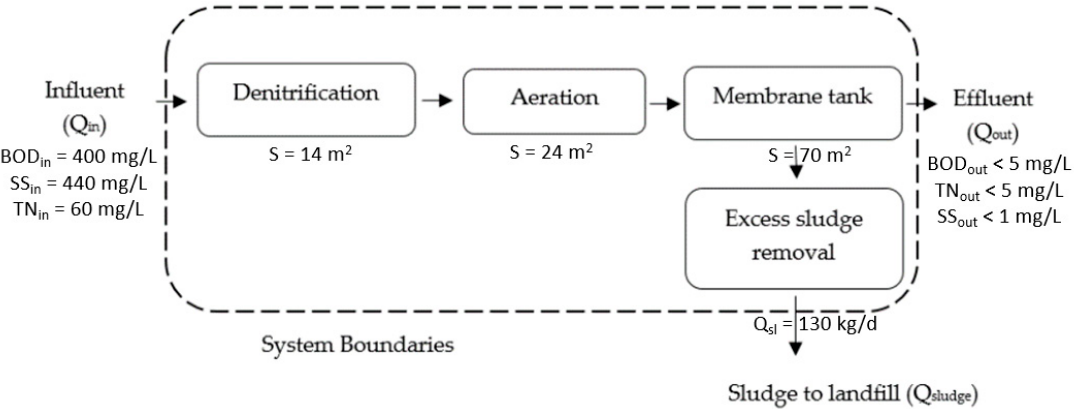
Figure 2. Membrane bioreactor unit system.